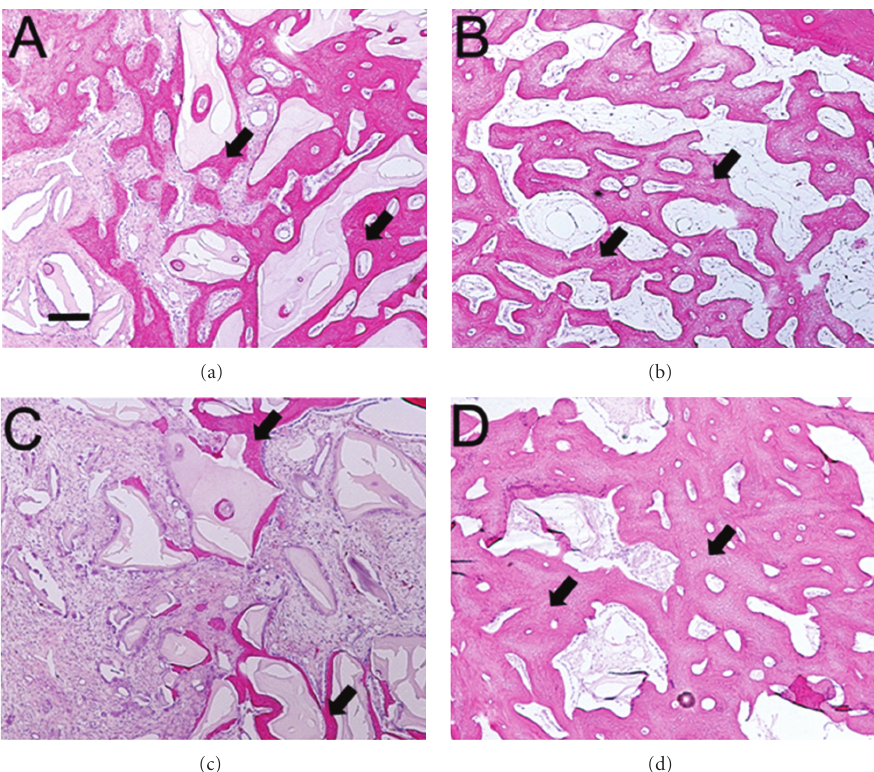
Figure 5: Representative hematoxylin-eosin (a)–(d) images of midsockets from the 4th premolar at six weeks following extractions and material placements. (a) bovine xenograft particulate and collagen plug (X), (b) bone putty only (Bp), (c) xenograft particles sandwiched between layers of bone putty placed in the coronal and apical aspect, (Bp-X-Bp), and (d) a 3:1 mixture by weight of bone putty and xenograft particles, respectively (3Bp-X). Arrows highlight newly formed bone between xenograft particles or in Bp only grafted sockets (b). Scale bar = 200 microns, 40x